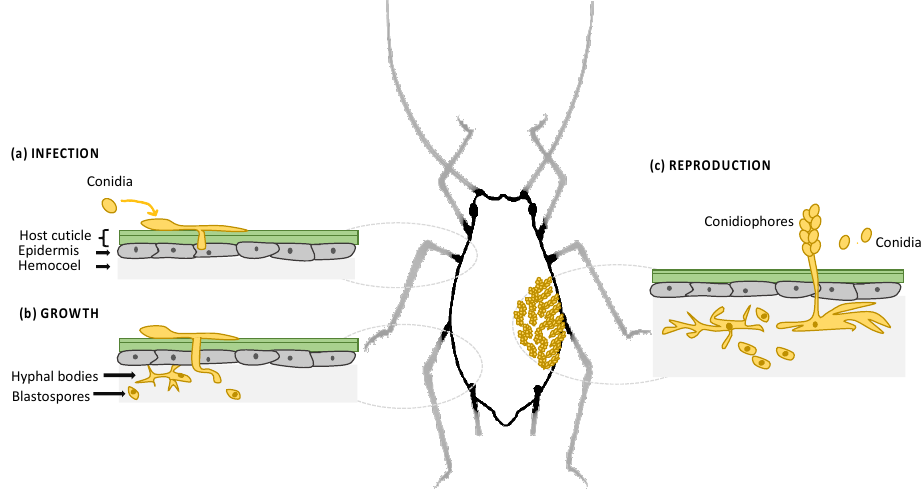
Figure 1. Illustrative schema of the infection path of hypocrealean pathogenic fungi (case of Beauveria bassiana ) in an arthropod host (case of aphids). ( a ) Infection: presented by the conidial attachment, germination, production of appressorial structures and penetration of the host. ( b ) Growth: described by the fungus’ proliferation through hyphal bodies and blastospores, as well as secondary metabolite production in the hemocoel. ( c ) Reproduction: presented by the fungal outgrowth, where the asexual conidia are passively released and a new cycle of infection is initiated.